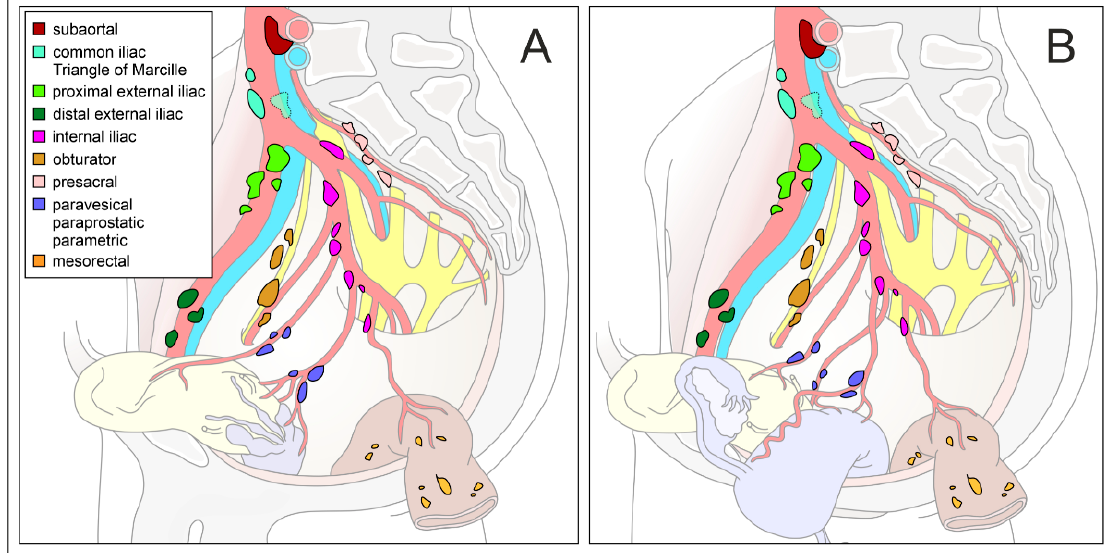
Figure 1. Schematic diagram of pelvic lymph node compartments. Mediolateral view of a right-sided male ( A ) and female ( B ) hemipelvis with pelvic organs and supplying arteries. Regional lymph nodes are colored differently (inserted legend in ( A ). Modified according to the Committee on Classification of Regional Lymph Nodes of the Japan Society of Clinical Oncology [4].